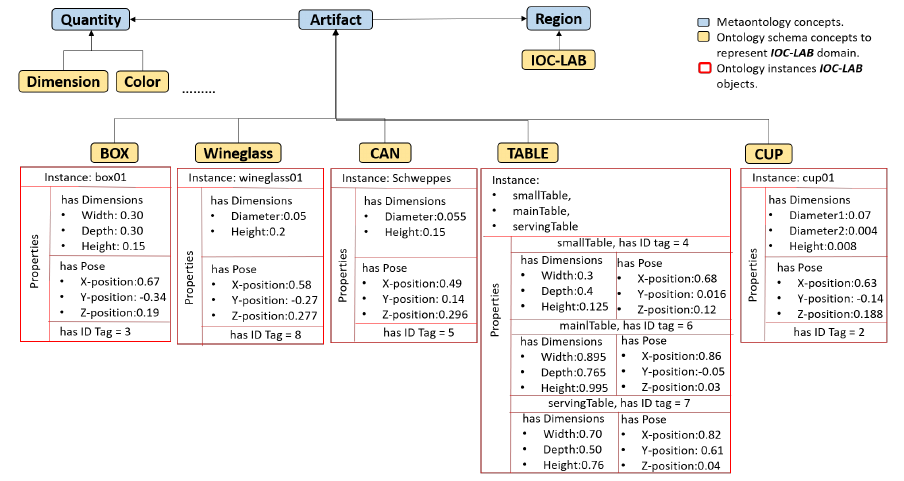
Figure 8. Taxonomy representation of the IOC-Lab domain in the PMK framework. The concepts of region, artifact, and quantity are inherited from Workspace, Wsobject, and Feature classes, respectively. The Quantity describes the features of each instance as shown in the properties part in the instantiated artifacts (the orientation information of the objects poses is not included in order to simplify the